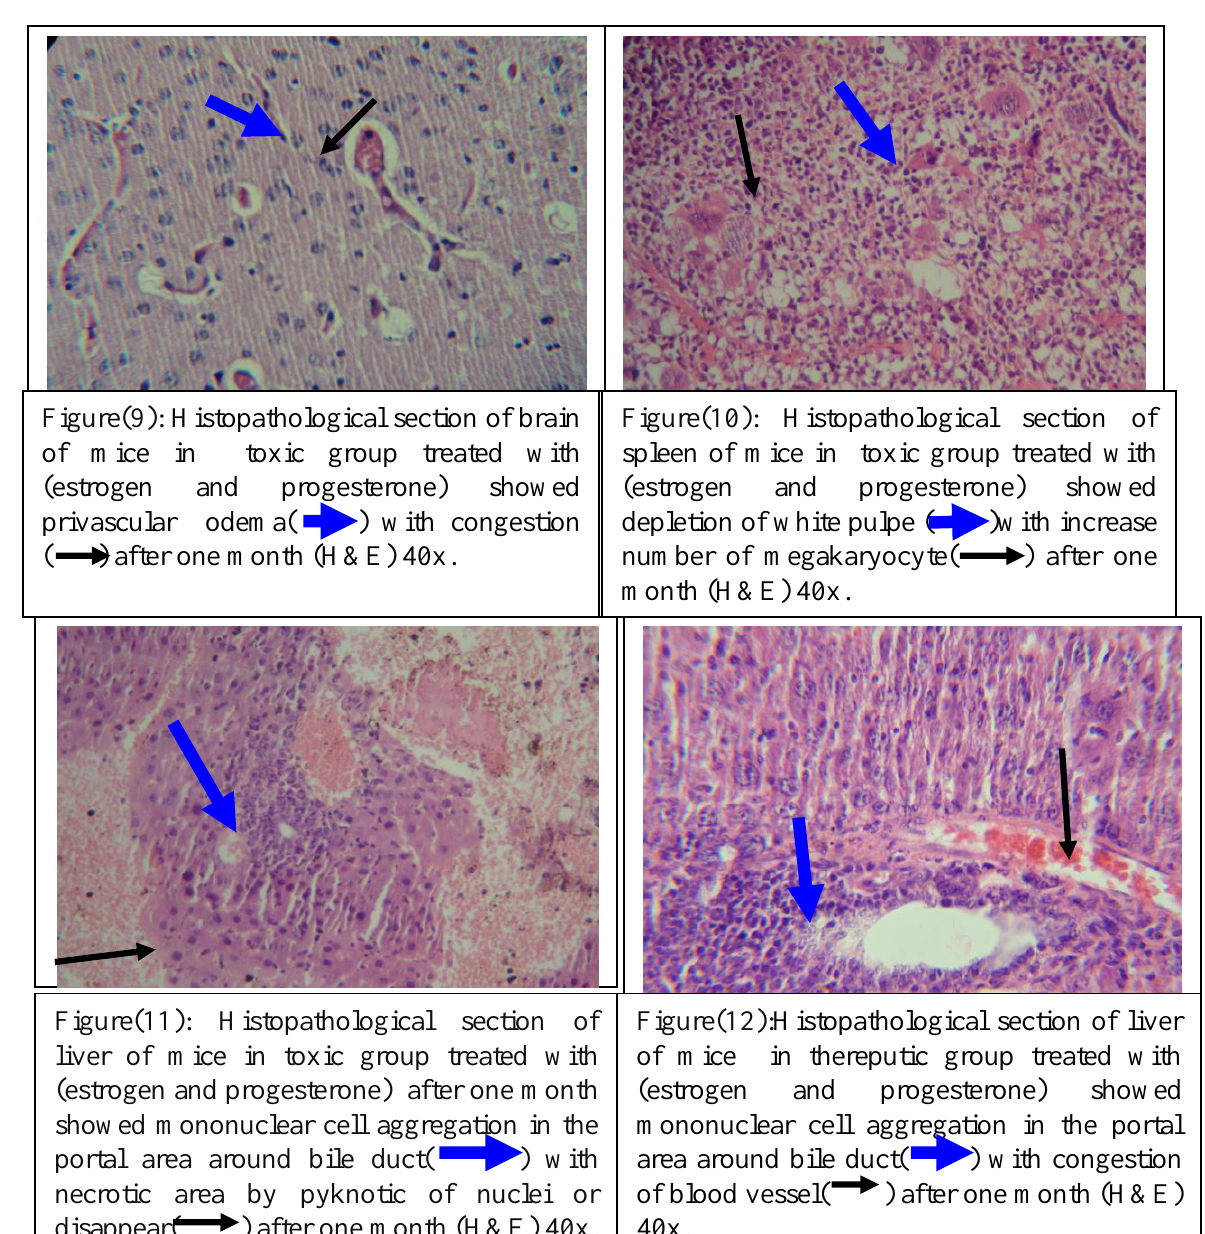
Figure(11): Histopathological section of liver of mice in toxic group treated with (estrogen and progesterone) after one month showed mononuclear cell aggregation in the portal area around bile duct( ) with necrotic area by pyknotic of nuclei or disappear( ) after one month (H&E) 40x.